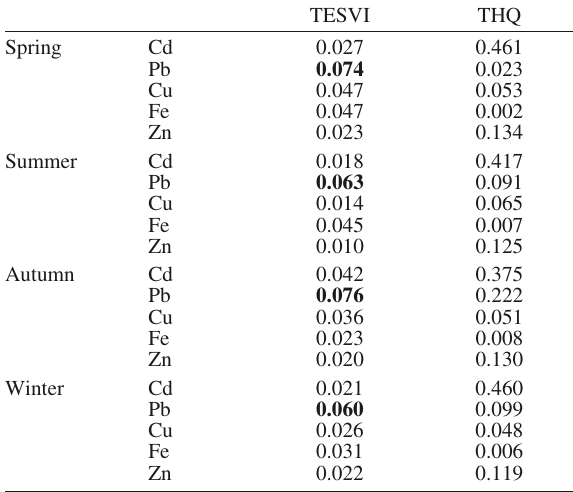
Table 2. – Trace Element Spatial Variation Index (TESVI) and target hazard quotient (THQ) values calculated from trace element mean concentrations in R. decussatus from the Tunisian coast: Ghar el Melh, the North Lake and the South Lake. Numbers indicate the highest value of each TE per season. Numbers in bold indicate the TEs with the highest